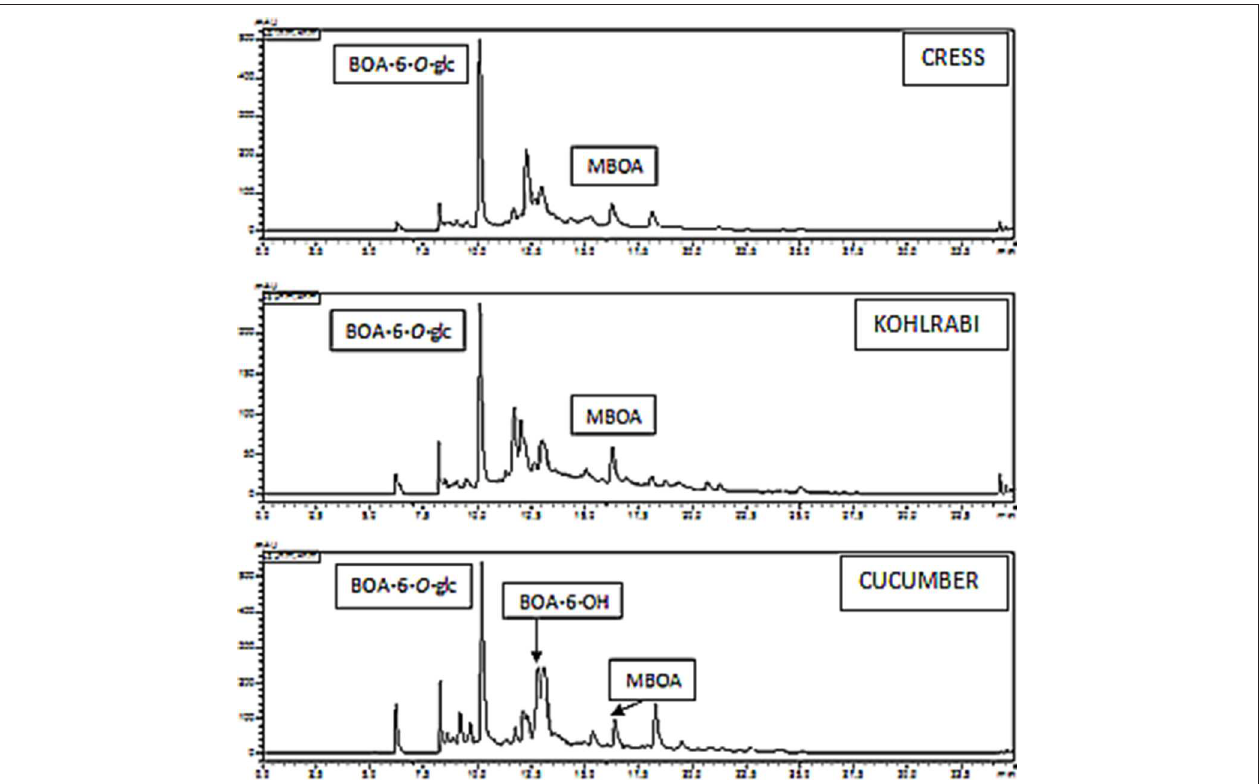
FIGURE 6 | Cucumber, kohlrabi, and cress demethylate MBOA; the demethylation product BOA-6-OH is glucosylated, and the glucoside accumulates in the roots prior to exudation. TABLE 1 | HPLC analyses were performed to determine the contents of BOA-6- O -glucoside, ( µ mol/gFW) in the roots of cress, kohlrabi and cucumber seedlings when exposed for 48h to 0.5mM DIBOA, BOA, BOA-6-OH, and MBOA. BOA-6-O-glucoside DIBOA (8) derived from: